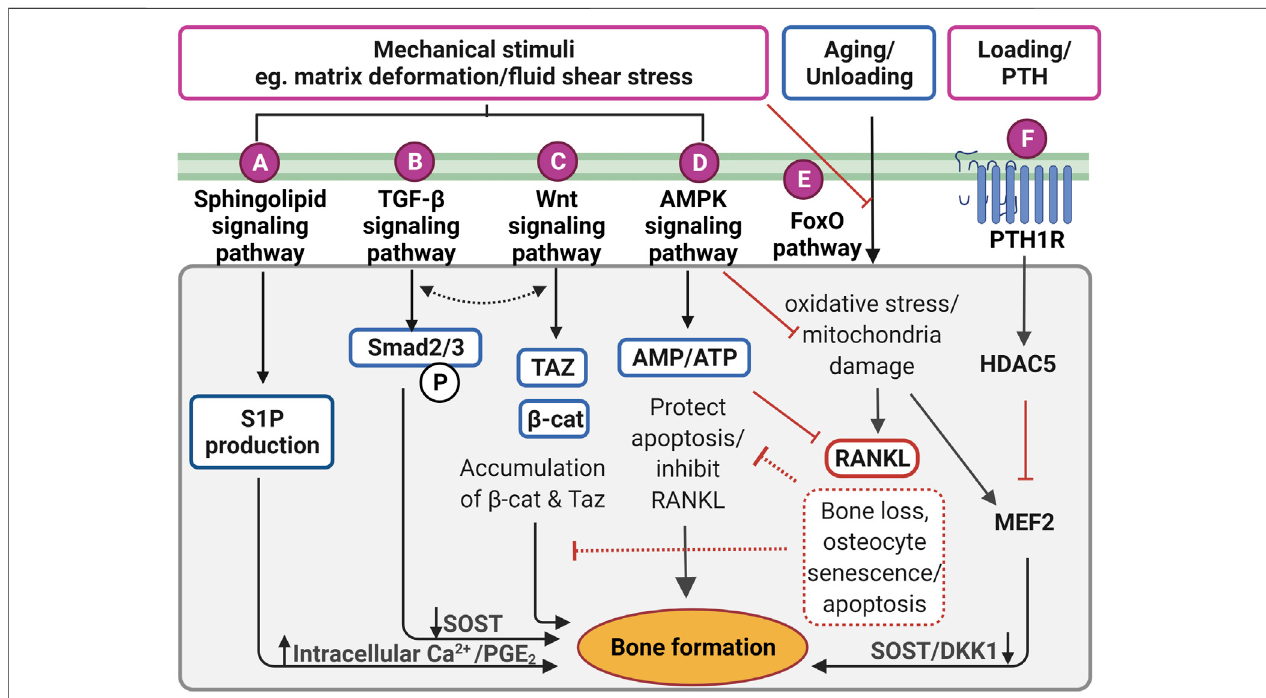
FIGURE 4 | Proposed mechanotransduction pathways in osteocytes for therapeutic targets showing intracellular signaling in response to the mechanical stimulation. (A) Pulsatile fl uid fl owtriggeredsphingolipidsignalingtoregulatethelipidmediatorssuchassphingosine-1-phosphate(S1P)productionthatupregulatesthe intracellular calcium ions (Ca 2+ ) levels and prostaglandin E2 (PGE 2 ) synthesis/release in osteocytes. (B) Fluid shear stress upregulates suppressor of mothers against decapentaplegic2/3(Smad2/3)phosphorylationtriggeringtransforminggrowthfactor-beta(TGF- β )signaling,resultinginsclerostin(SOST)downregulation.Thisis independent ofTGF- β receptor-induced response. (C) Wnt/ β -catenin signaling can be elicited by direct response to extracellular matrix deformation via integrins or fl uid shear stress, which is important to maintain osteocyte viability and anabolic effect by accumulating Taz and β -catenin ( β -cat). Interestingly, both TGF- β and Wnt/ β signaling may interact with each other to induce bone formation, however, the exact mechanism is not clear. (D) Under mechanical stimuli, adenosine monophosphate (AMP)-activated protein kinase (AMPK) signaling governs energy homeostasis in osteocytes by increasing the AMP/adenosine triphosphate (ATP) ratio for inhibiting apoptosis and decrease receptor activator of nuclear factor- κ B ligand (RANKL) expression. (E) Forkhead box O (FoxO) signaling is activated to protect osteocytes from oxidative stress and mitochondria damage caused by aging and reduced mechanical stimulation. Without FoxO activation, osteocytes lead to senescence and apoptosis. (F) Parathyroid hormone receptor (PTHr) is activated both by mechanical stimulation as well as parathyroid hormone. This receptor upregulates histone deacetylase 5 (HDAC5), which inhibits myocyte enhancer factor 2 (MEF2C), responsible for negative Wnt signaling molecules, SOST and dickkopf-related protein 1 (DKK1). Figure created using